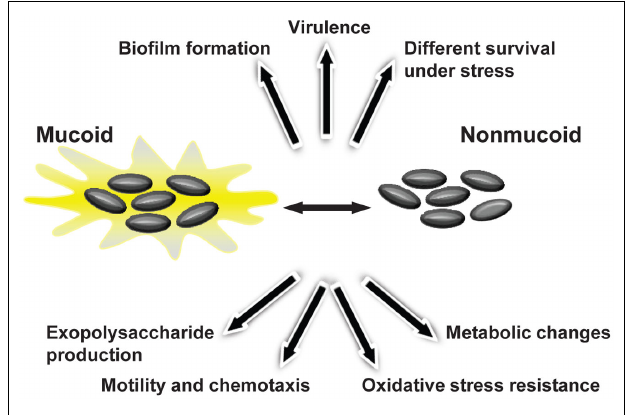
FIGURE 4 | Bacterial phenotypes displaying variation during Bc c mucoid vs. non-mucoid transition that occurs in persistently colonized lungs of cystic fibrosis